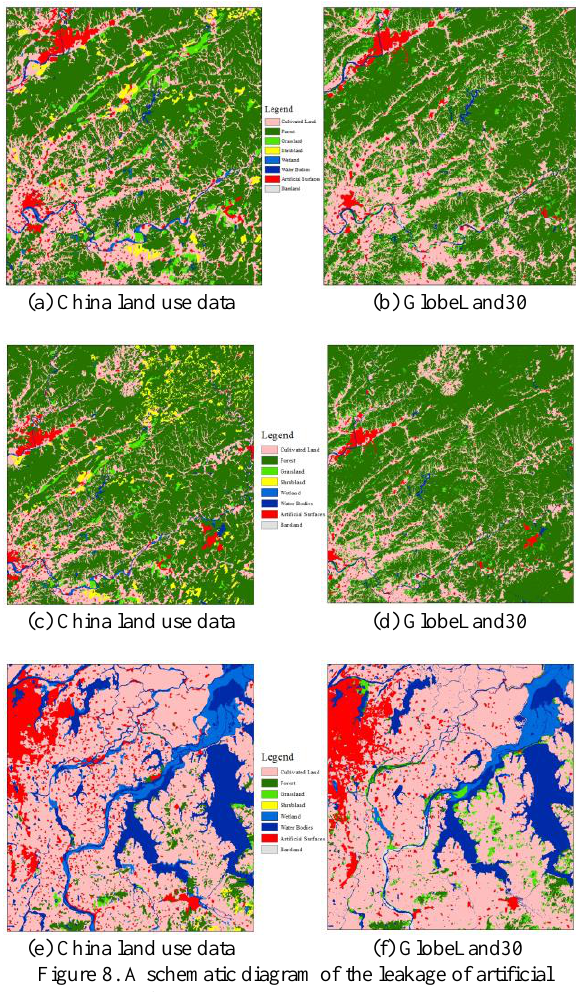
Figure 8. A schematic diagram of the leakage of artificial surfaces, shrubland in Jiangxi